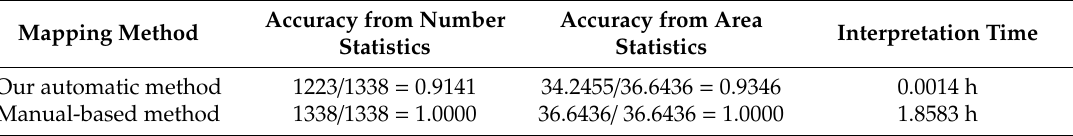
Table 7. Comparison of the accuracy and interpretation time achieved using the proposed automatic method with the manual-based